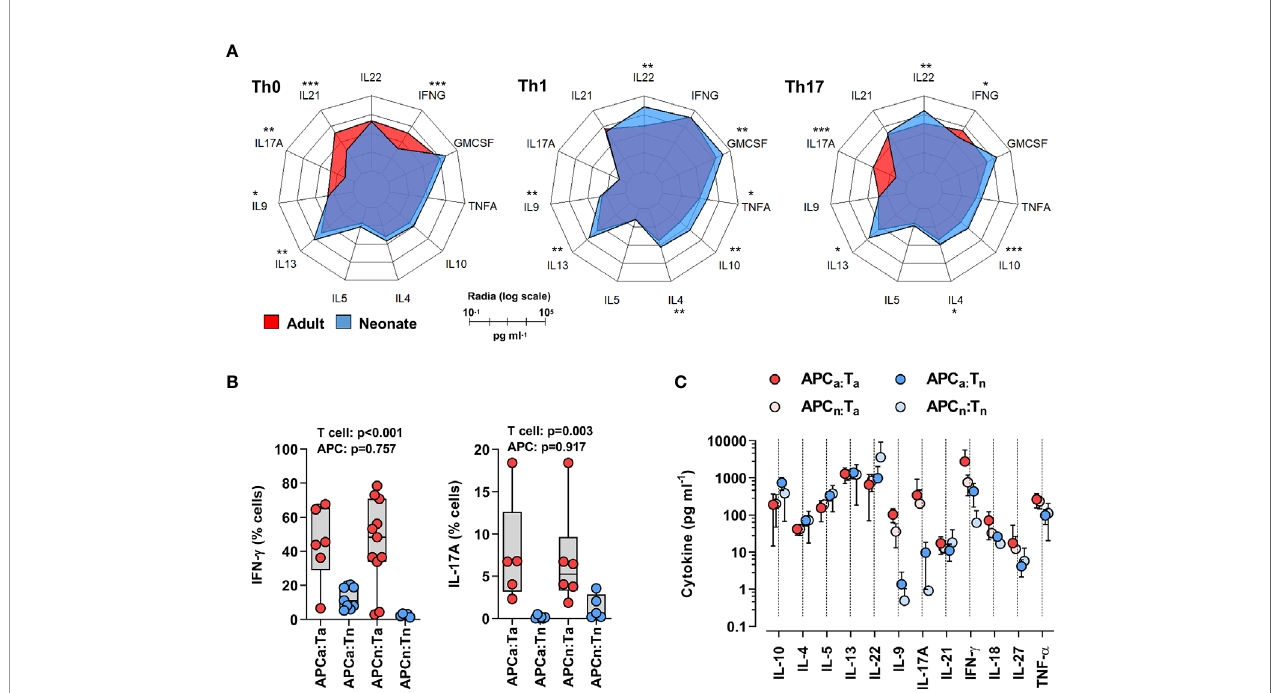
FIGURE 1 | Neonatal T cells are inherently biased against Th17 responses independent of antigen-presenting cell signals. (A) Radar plots of cytokines produced by adult or neonatal naïve CD4 T cells 6 days post-stimulation (anti-CD3/CD28 beads) in Th0- (no exogenous cytokines), Th1- (IL-12) or Th17- (IL-1 b , IL-6 and IL-23) polarizing conditions. Data are presented on a log-10 scale (pg ml − 1 ) averaged from two separate sets of experiments that include a total of 6-12 subjects per cytokine polarizing condition per age group; P values for each cytokine were calculated by two-tailed Mann-Whitney U test using non-logarithmic values and correction was applied for multiple comparisons using the Benjamini-Hochberg method; *p < 0.05; **p < 0.01; ***p < 0.001; (B) Intracellular IL-17 and IFN- g detection (by fl ow cytometry) in adult (red) or neonatal (blue) naïve CD4 T cells stimulated using soluble anti-CD3 antibody (OKT3) for 6 days in presence of carboxy fl uorescein succinimidyl ester (CFSE)-labeled allogeneic neonatal (N) or adult (A) antigen-presenting cells (APC a = adult APCs, APC n = neonatal APCs, T a = adult T cells, T n = neonatal T cells). Data are aggregated from 11 independent experiments each using 2 freshly collected (same day) neonatal and adult samples, with p values for the effect of T cell or APC age on cytokine response, using a 2-way ANOVA; (C) Corresponding cytokine measurement in supernatants (ELISA); means with 95%